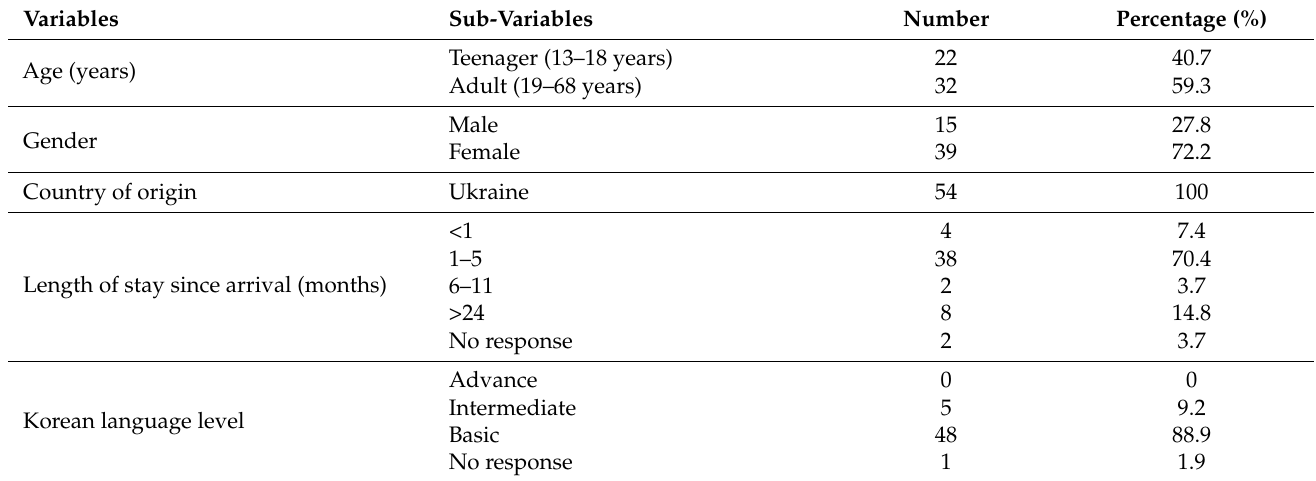
Table 1. Demographic characteristics of